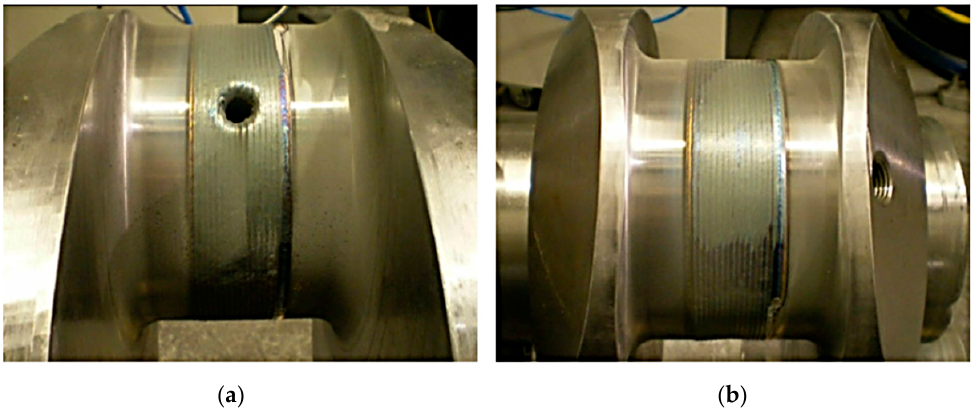
Figure 9. DED crankshaft segment ( a ) around oil bore, ( b ) on the bottom side at the lower dead center position [86].